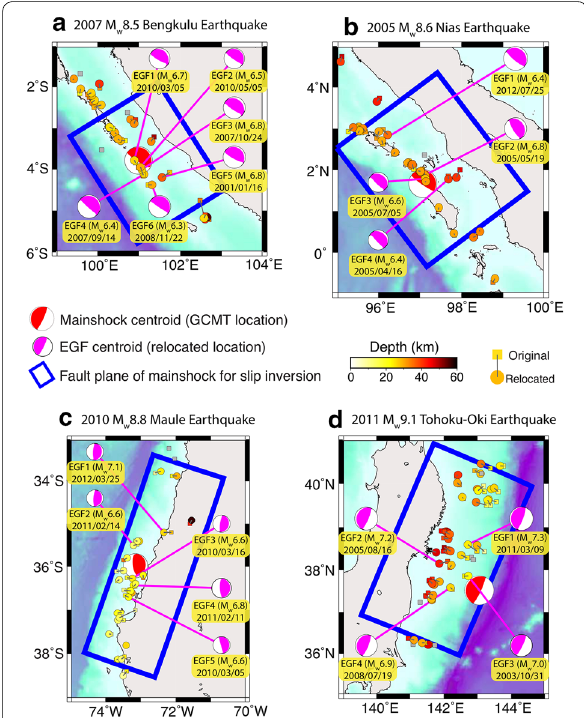
Fig. 1 Relocation results and EGF selection for the a Bengkulu, b Nias, c Maule, and d Tohoku‑Oki earthquakes and surrounding interplate earthquakes. The interplate earthquakes ( 6.0 ≤ M W ≤ 7.3 ) that were detected during 2001–2016 are shown, with the original locations from the ISC catalog (squares; International Seismological Centre 2019) and the relocated events in this study (circles) color‑coded by depth. Gray squares denote the events that are not relocated (see Additional file 1: Tables S1–S4 for further details). The beach ball plots represent the focal mechanisms of the selected EGF (pink) and mainshock (red) events, with the locations of the mainshocks and focal mechanisms from the EGF events and the mainshocks taken from the GCMT catalog (Dziewoński et al. 1981; Ekström et al. 2012). The blue rectangles denote the assigned fault planes for the slip inversion